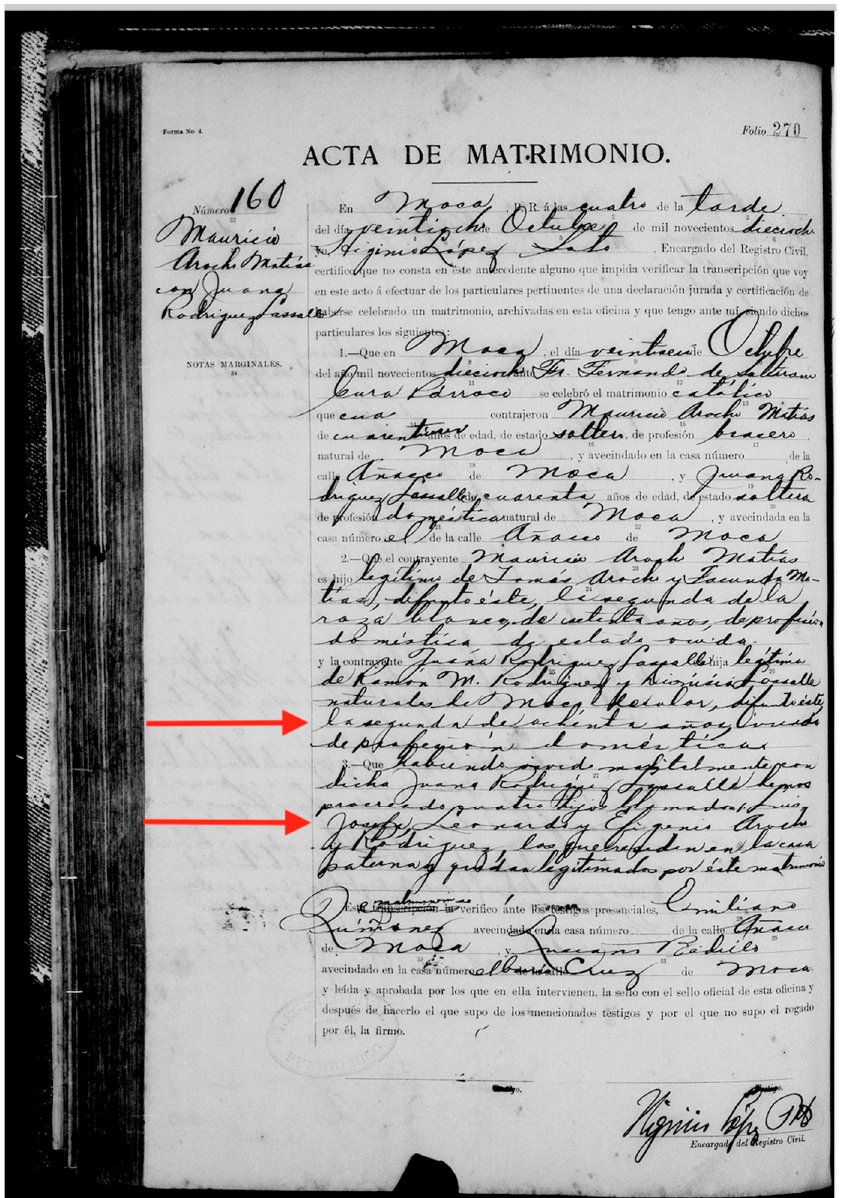
Figure 9. Mauricio Arocho Matias and Juana Rodriguez Lassalle, Marriage Registration, 1918. First arrow indicates name and age of Dionicia Lassalle, 80 in October 1918; the second notes the couple’s four children, Luis, Josefa, Leonardo, and Efigenio Arocho Rodriguez. “Puerto Rico, Registro Civil, 1805–2001,” database with images, FamilySearch (https://familysearch.org/ark:/61903/1:1:QVJD-8KVQ: 14 November 2019).